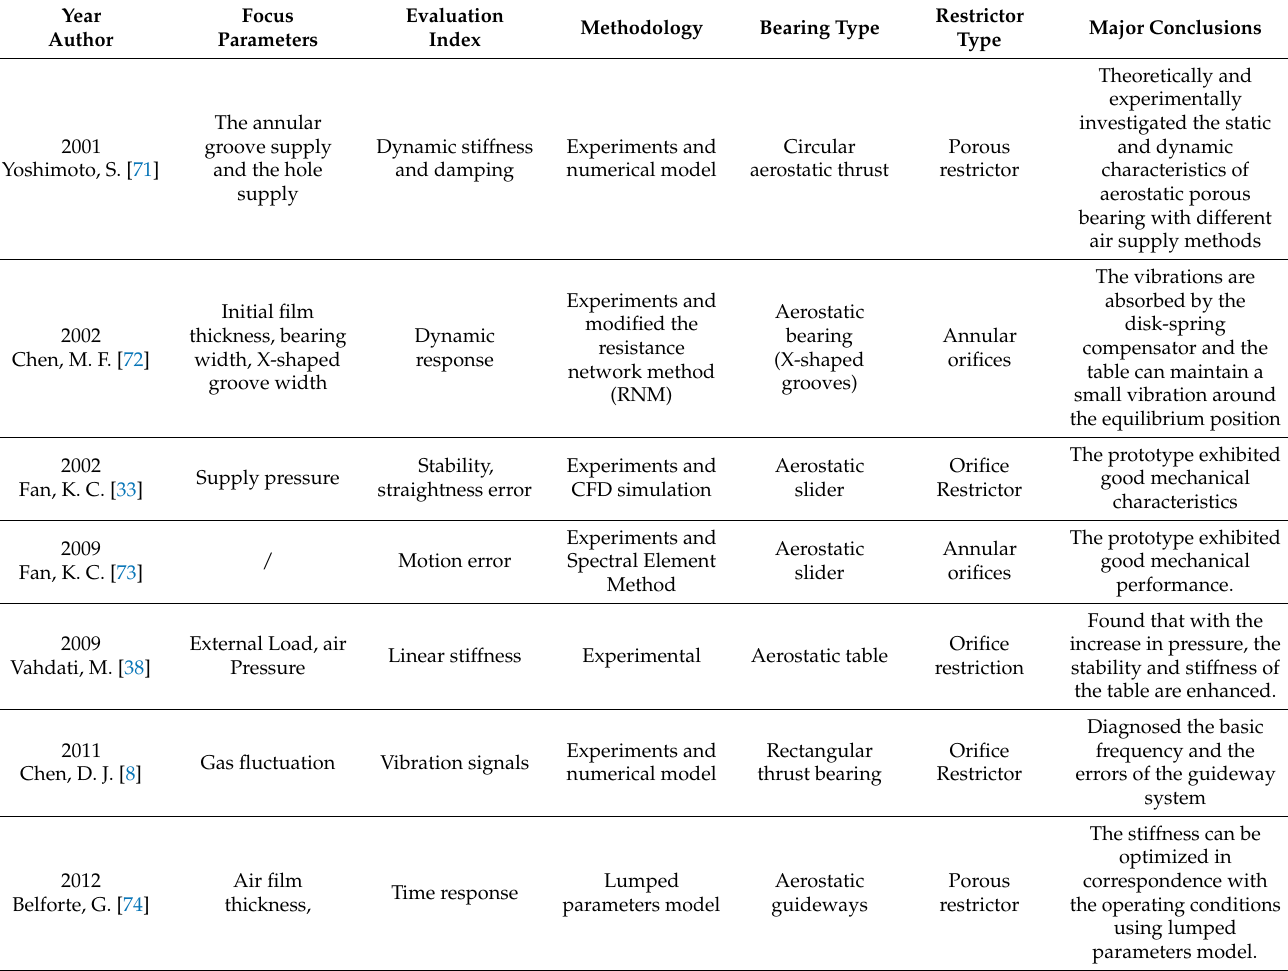
Table 2. Dynamic performance of